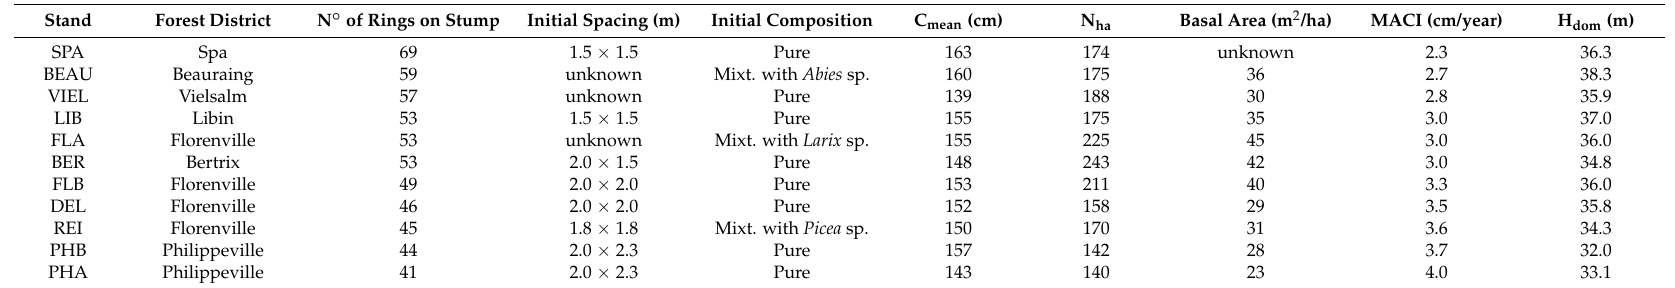
Table 1. General characteristics of the 11 sampled Douglas fir plantations. C mean : mean circumference of the Douglas firs; N ha : number of trees per hectare at the time of tree cutting; MACI: mean annual circumference increment; H dom : dominant